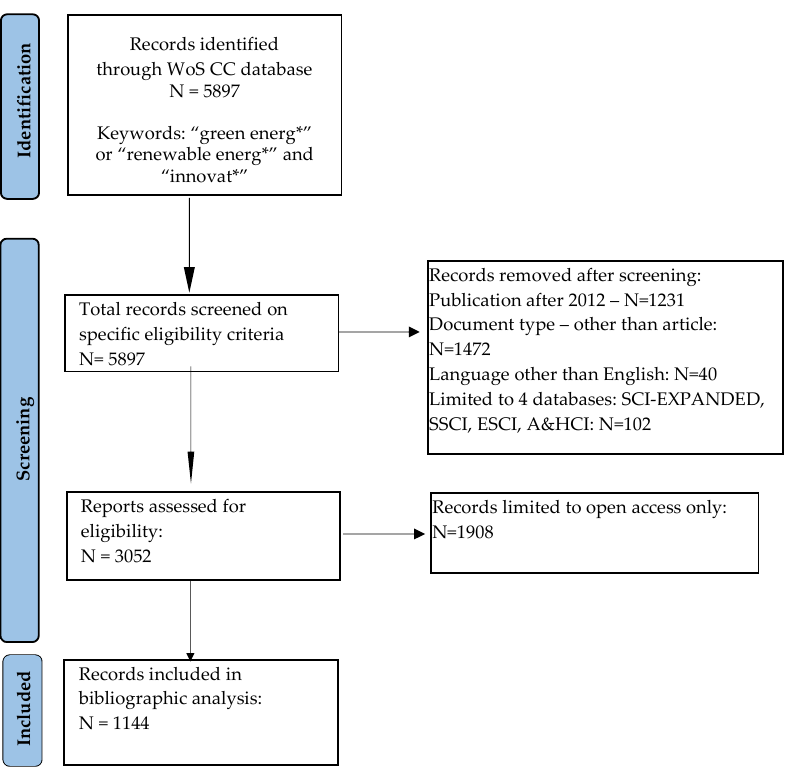
Figure 1. PRISMA flowchart [36].